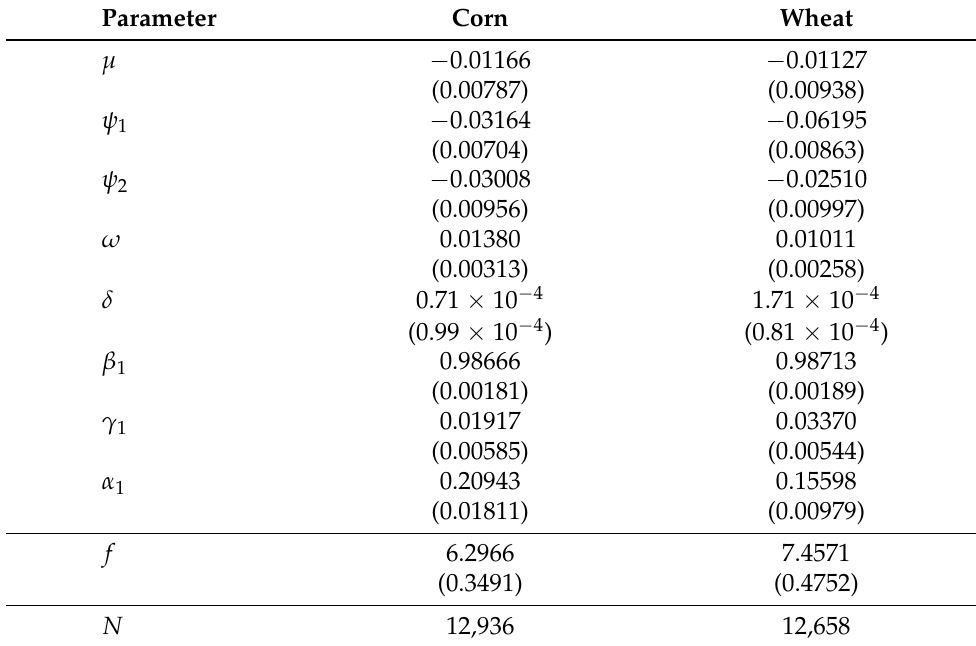
Table 2. Estimated EGARCH models for corn and wheat daily